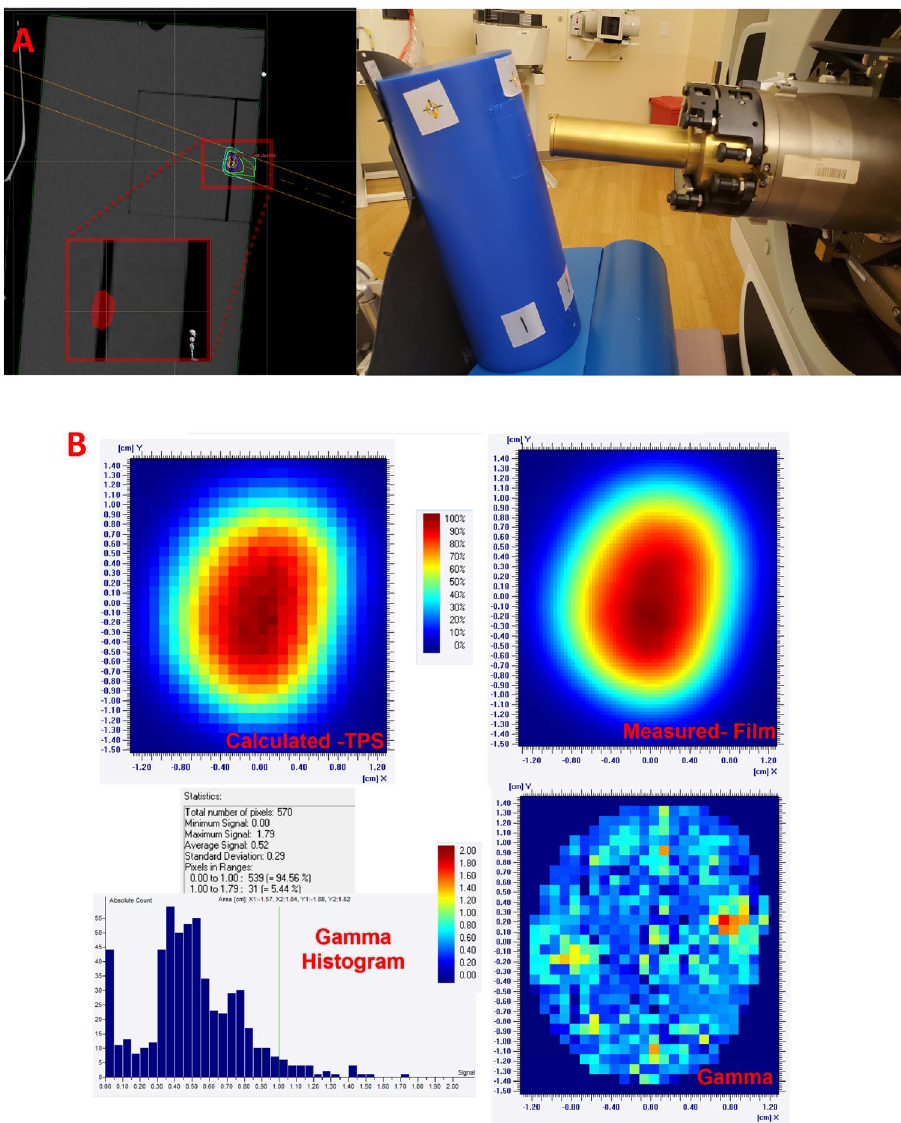
Figure 7. ( A ) End-to-end treatment planning and delivery for a pseudo ocular target (see zoomed inset, target is roughly 0.5 cm width, 0.8 cm length, and 0.4 cm thick at a depth of 2 cm) treated through a single enface beam. ( B ) The comparison of irradiated film with the calculated dose map along with gamma